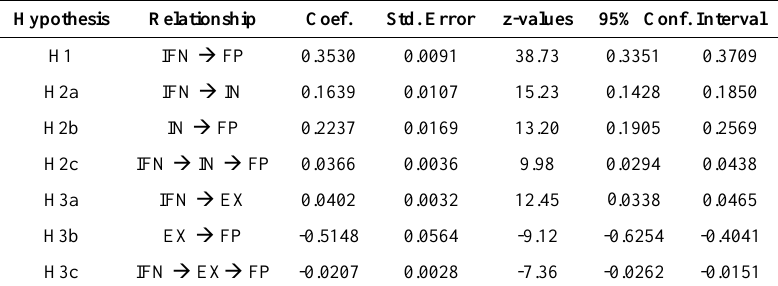
Table 2. Summary of Hypothesis Testing Path